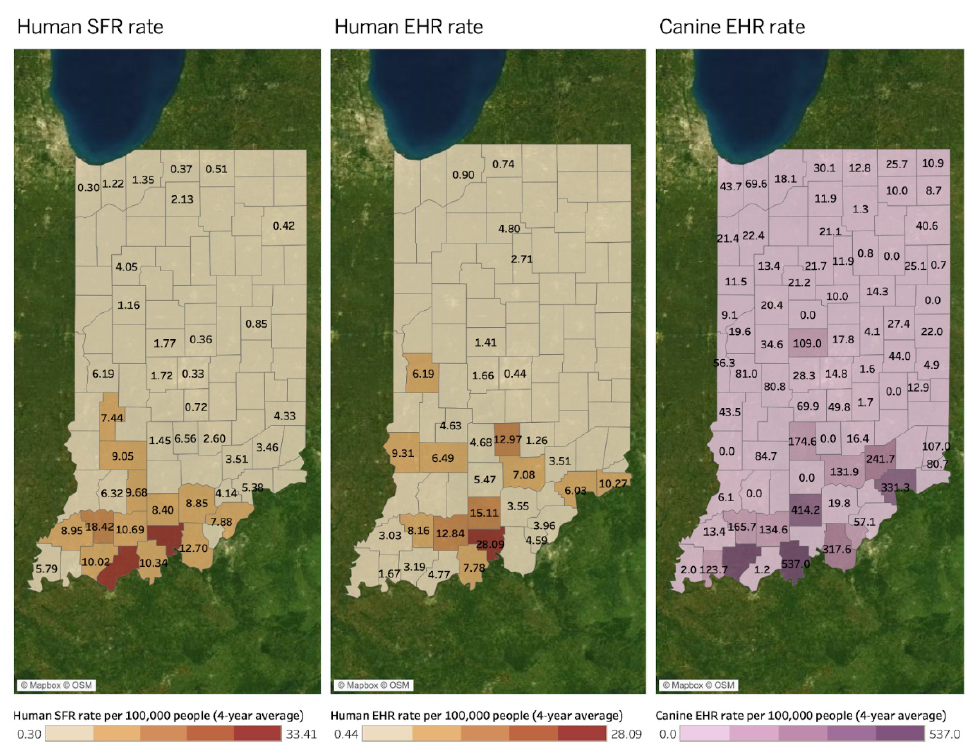
Figure 4. Human SFR and EHR, and canine EHR rates by county (4-year average between 2017 and 2020).